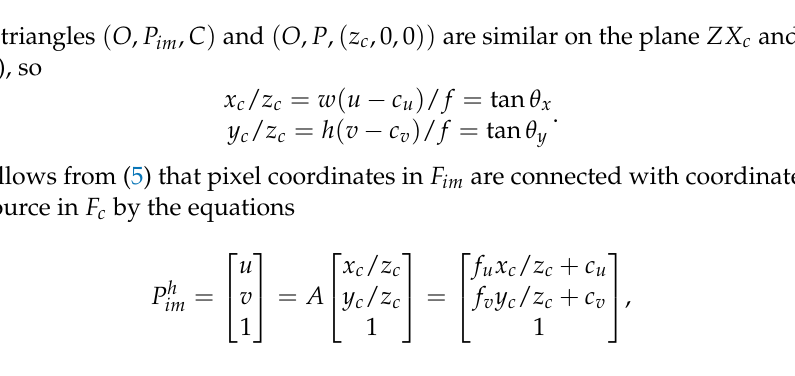
Figure 2. Virtual and real images for a camera with aperture O . The scene is projected on the plane XZ of frame F c . The coordinates of the point P in F c are denoted by x c , z c , and the u , c u are coordinates of points P , C on the axis U of frame F im